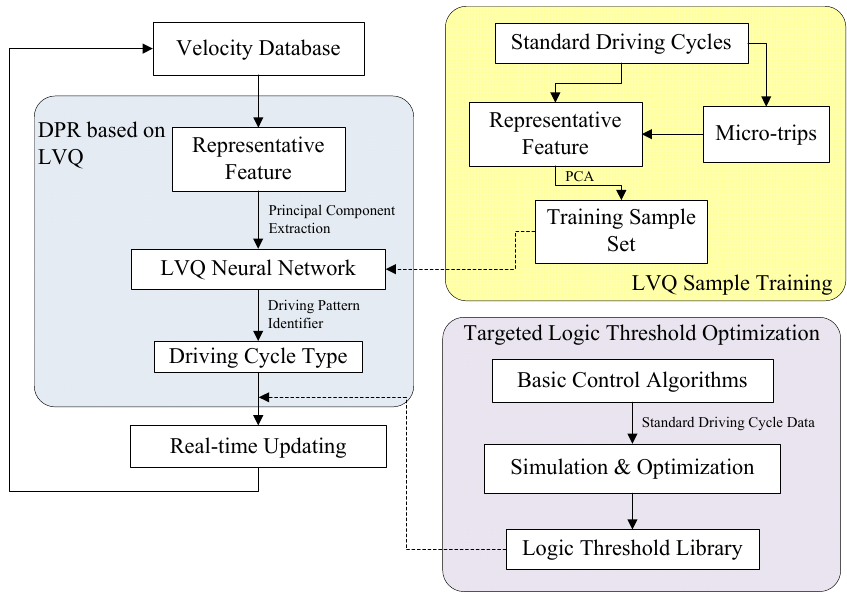
Figure 1. Control logic based on DPR.